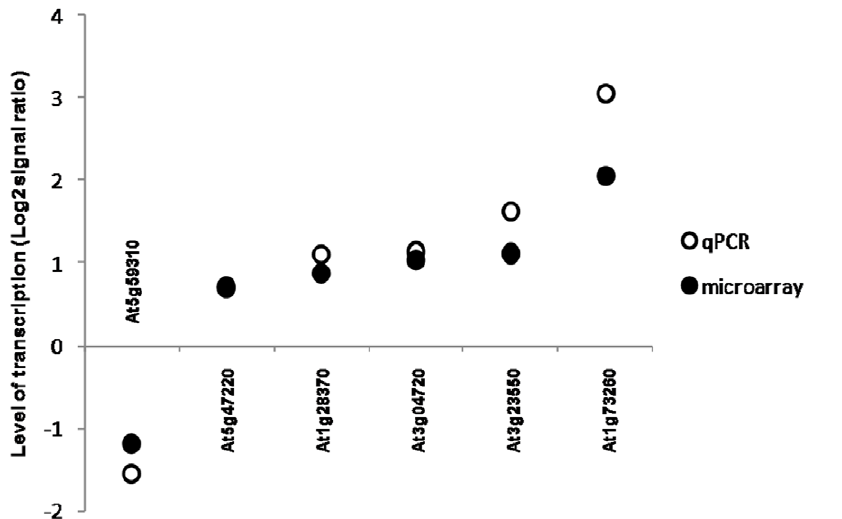
Figure 3. Validation of the results obtained in transcriptomic analysis by real-time polymerase chain reaction (qPCR). Six genes were selected from the 59 differentially expressed genes obtained by transcriptomic analysis (Table 2). Transcript abundance was standardized by reporting it to the constitutive At5g11770 gene. A log base 2 transformation was applied on the average transcript abundance level to obtain data similar to the transformed microarray